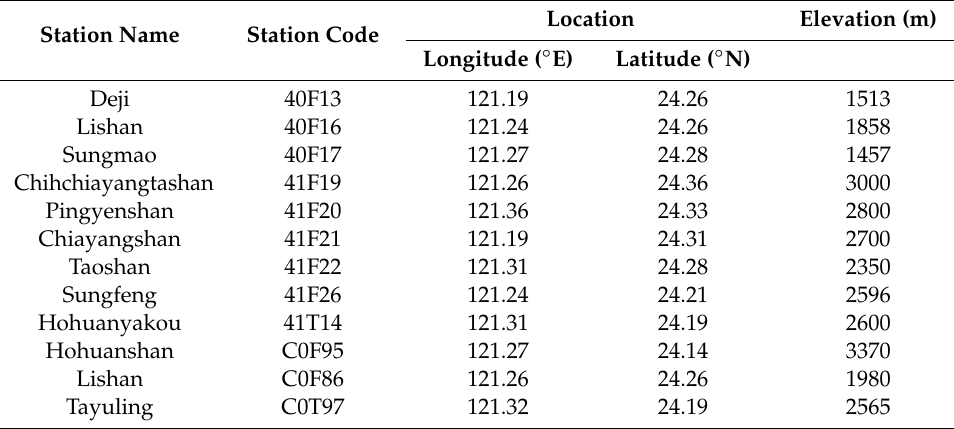
Table 1. Geographic information on the rain gages in the Deji Reservoir watersheds .